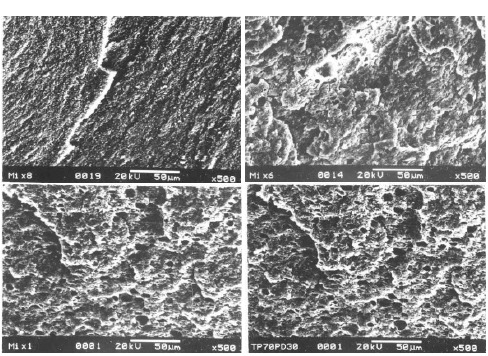
Fig. 2. Scanning electron micrographs showing irregular distribution of silicone rubber